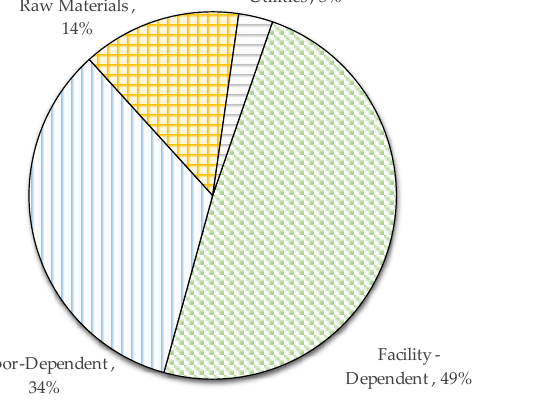
Figure 7. Annual operating cost breakdown (%): Scenario 3—3 USD/g—3.7 kg/batch.